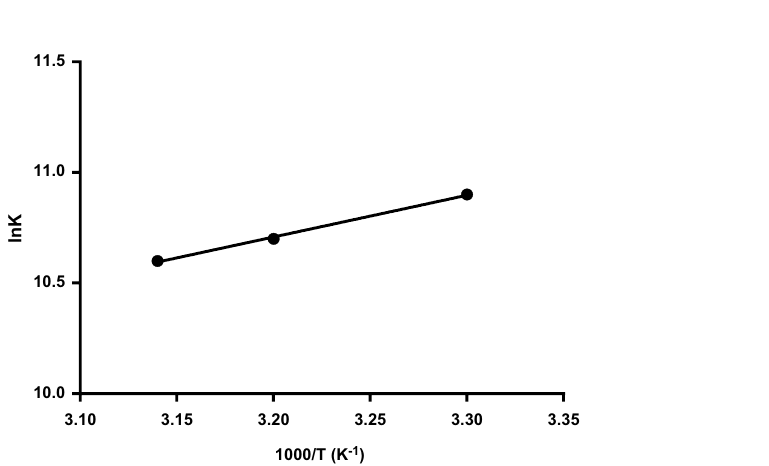
Figure 6. Van’t Hoff plot for BSA- MBZ